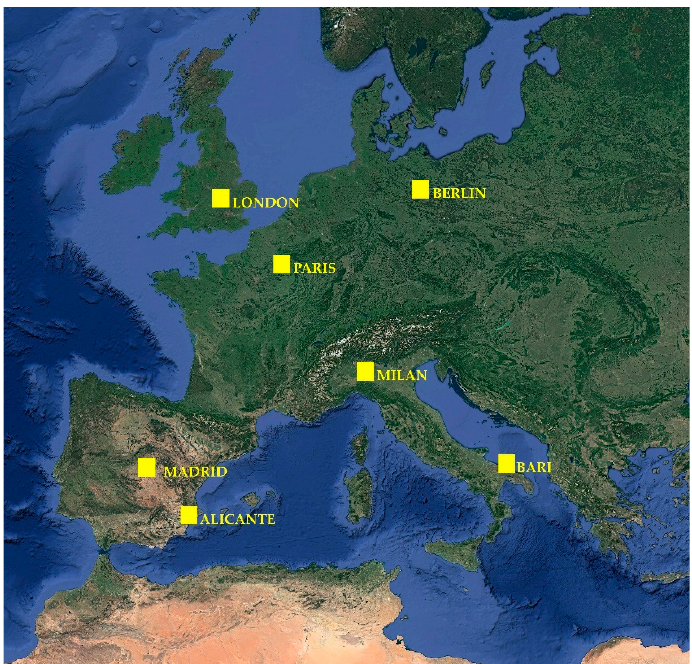
Figure 3. Study areas in Europe.